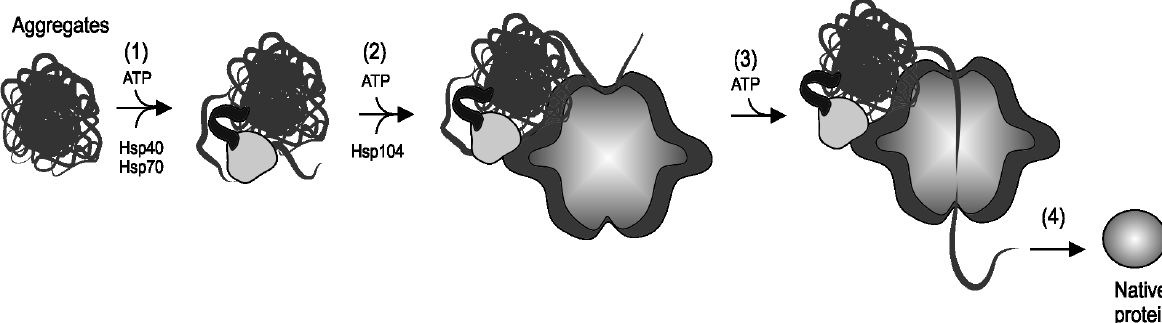
Figure 3 - A model for the cooperation between Hsp104, Hsp70 and Hsp40 to resolubilize aggregates. The chaperone system (Hsp40 and Hsp70, represented by black and light gray, respectively) identifies and associates with aggregates ( 1 ), from which Hsp104 can then interact directly through a small region of the Hsp104 M-domain ( 2 ), promoting interaction of Hsp104 with the aggregate. The sum of these interactions causes transmission of signals through the M-domain to NBD1, thereby coupling ATP hydrolysis to stimulate disaggregase activity by translocation through the central pore of Hsp104 ( 3 ). Following this, the unfolded polypeptide is released from Hsp104 and may spontaneously refold or is refolded to native protein with the assistance of other cellular chaperones ( 4 ) (modified from Miot et al.